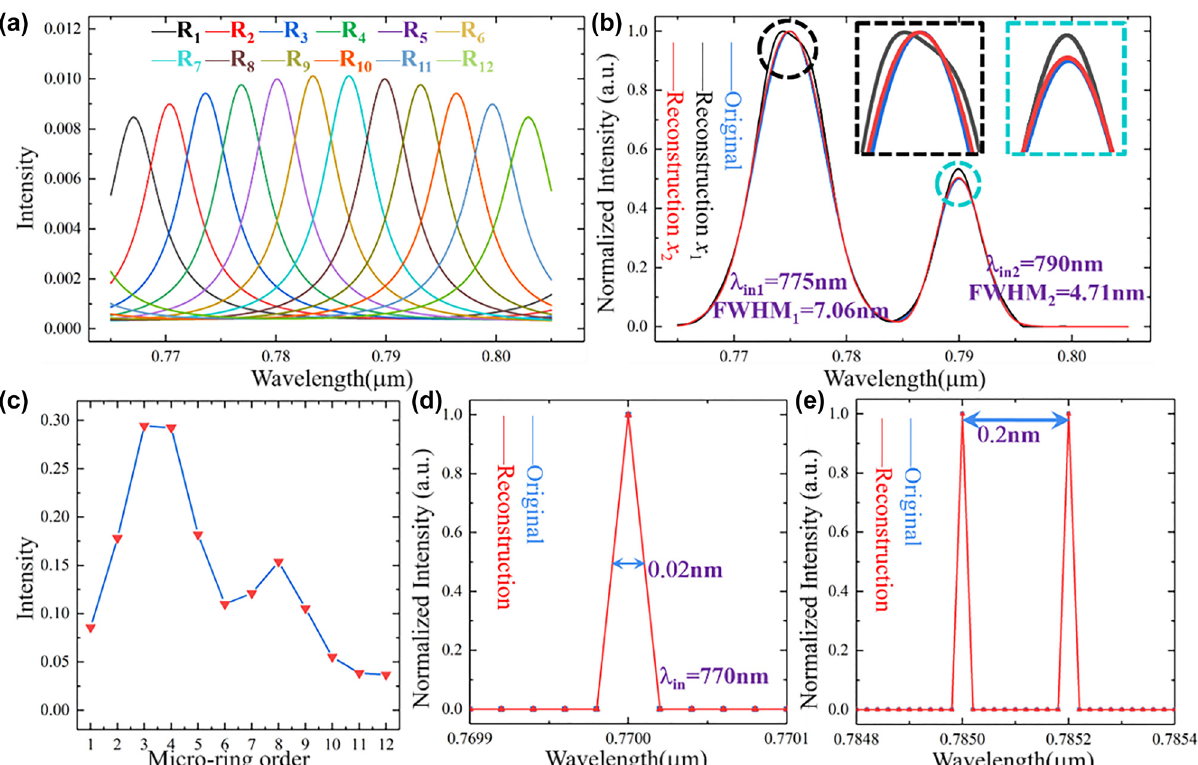
Figure 2: Unknown spectrum reconstruction process. (a) MRRs Drop spectrum under modulation. (b) Reconstruction results of double broadband spectrum. (c) Output values of incident spectrum at each micro-ring. (d) and (e) Reconstruction results of the single narrowband spectrum and two adjacent narrowband